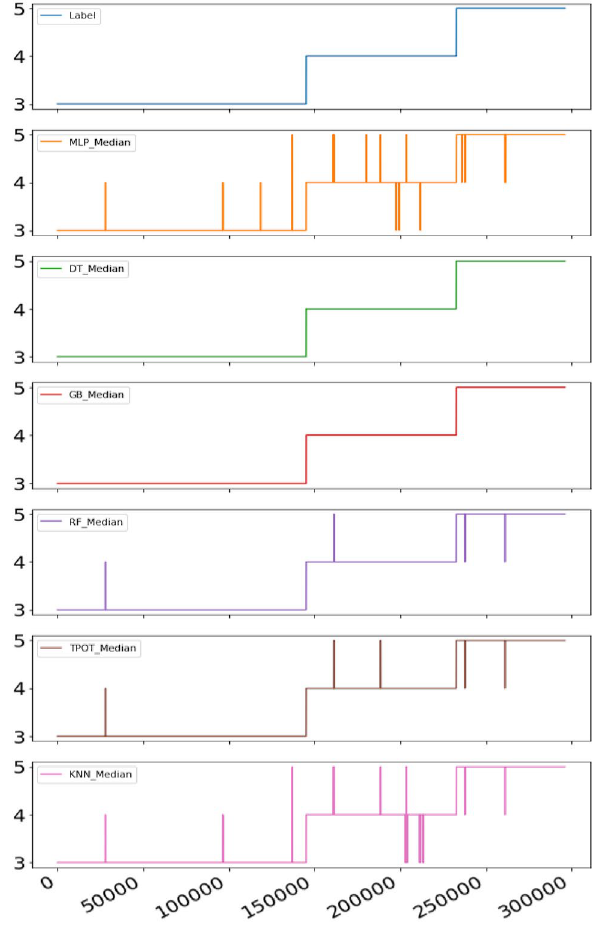
Fig. 9 Prediction from Case 4